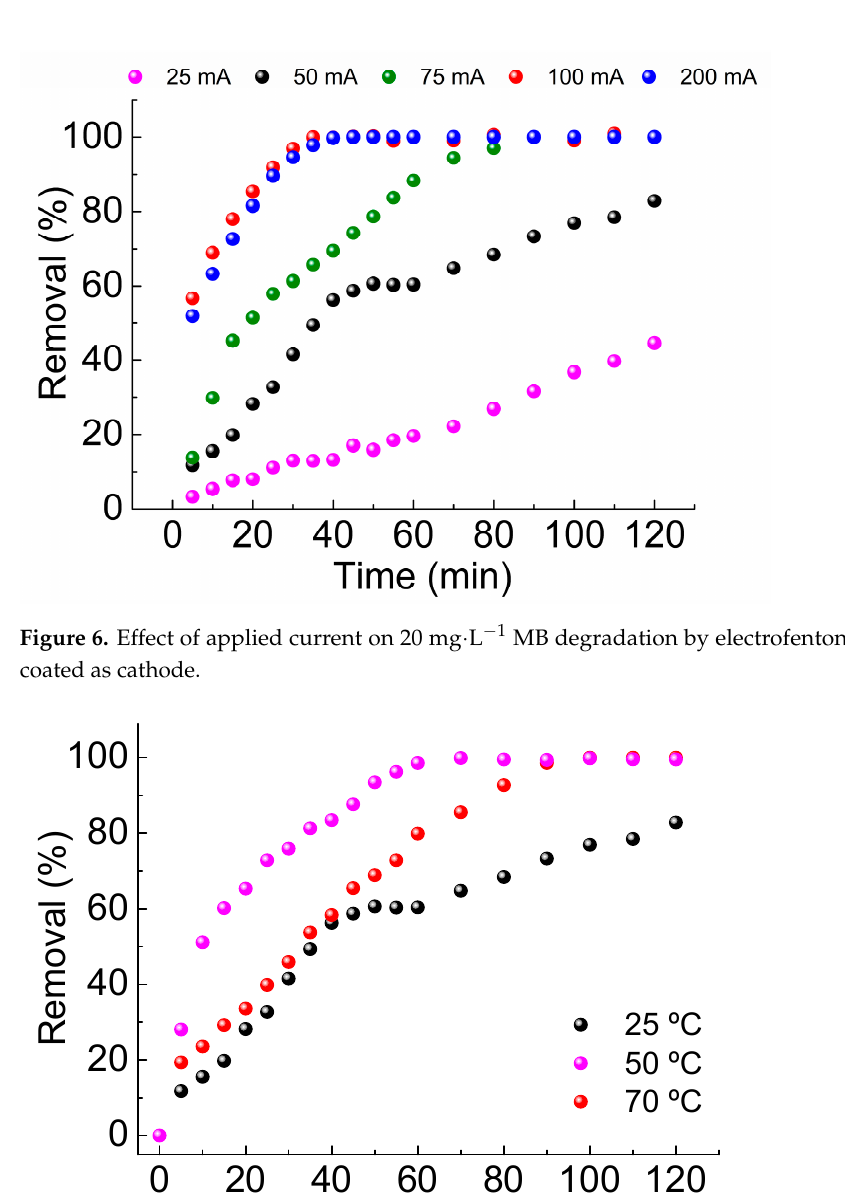
Figure 6. Effect of applied current on 20 mg·L − 1 MB degradation by electrofenton using RVC dip coated as cathode.